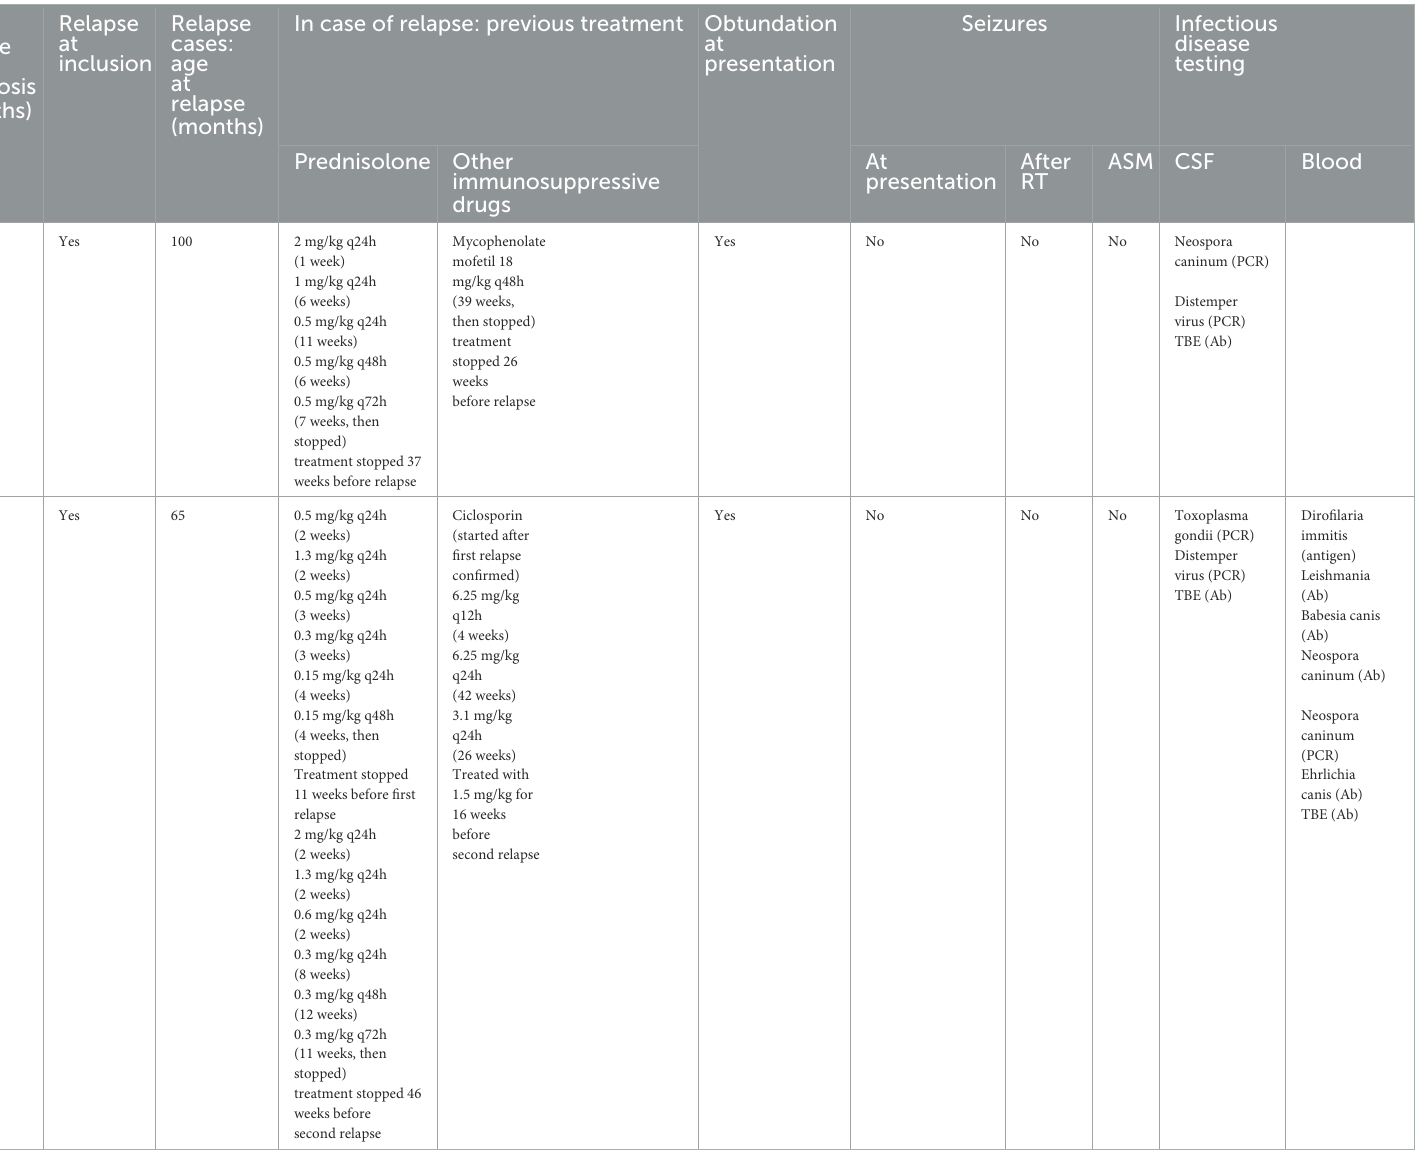
TABLE 1 Signalment. Case